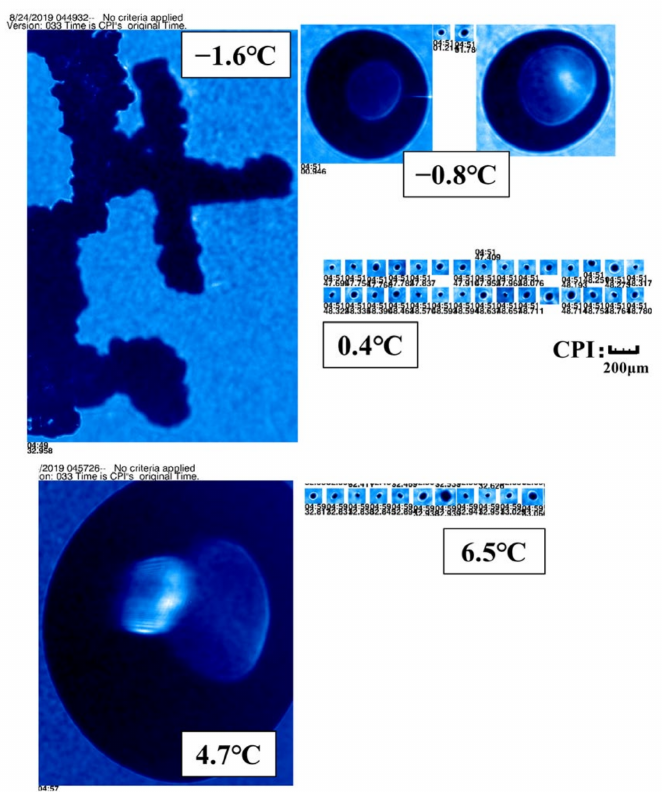
Figure 13. Particles image of the flight V4 on 24 August